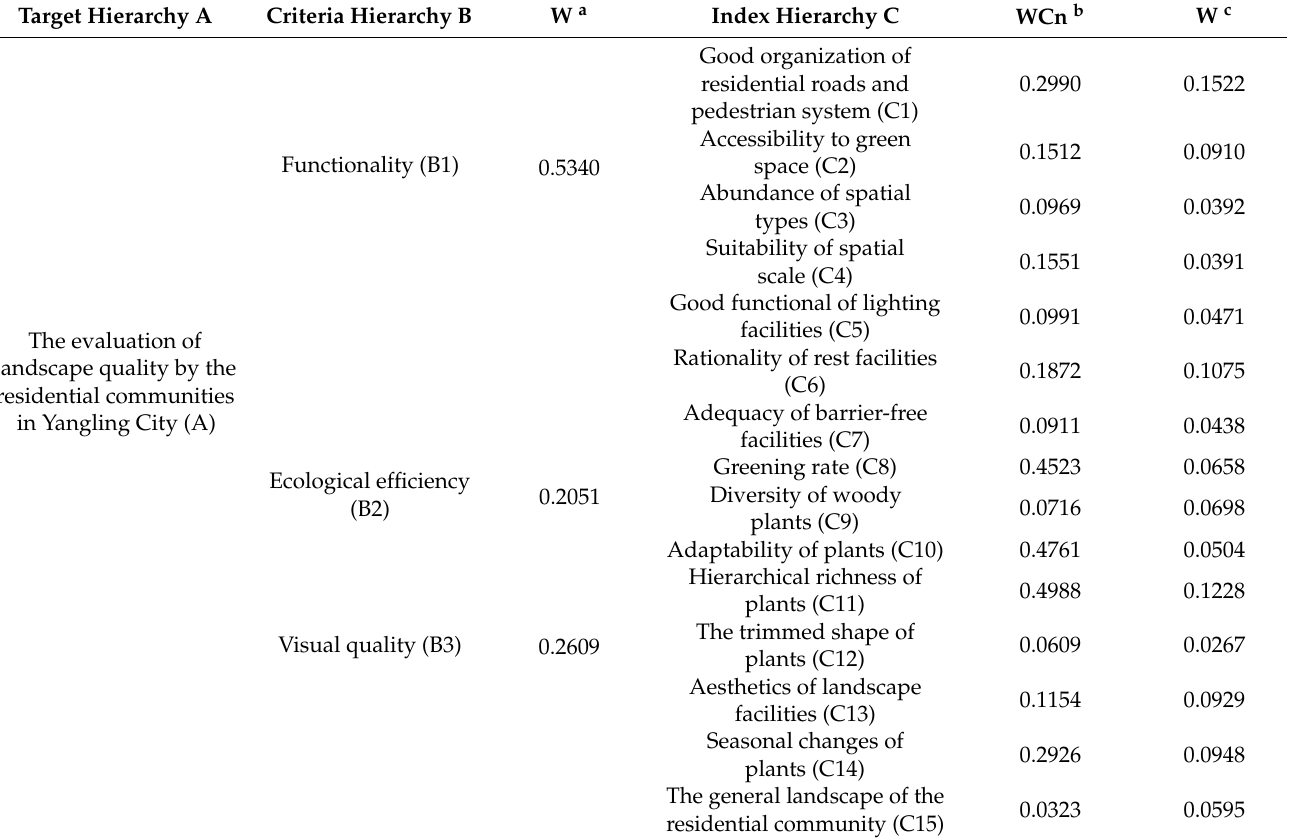
Table 3. Final comprehensive weights based on the landscape quality evaluation